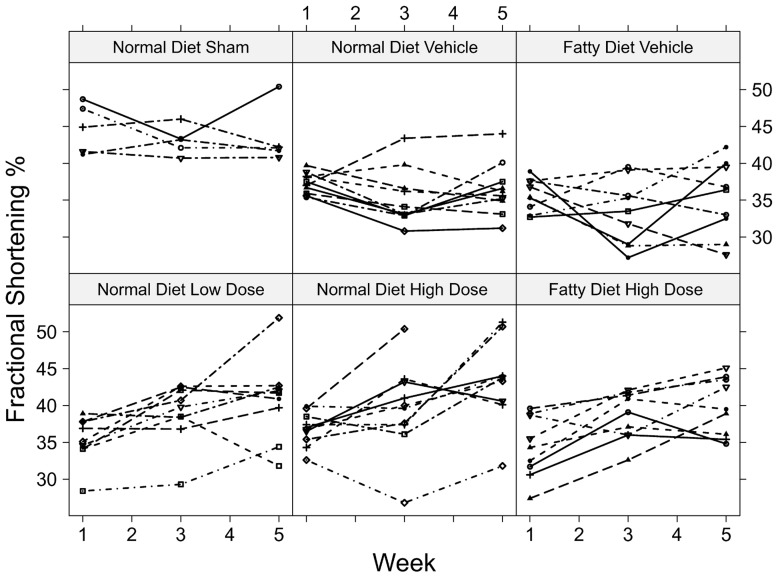
Effect of GGF2 treatment on cardiac function early after MI.Serial measurements of fractional shortening (FS) were acquired from post-MI rats at baseline (1 week post-MI), 2 weeks after GGF2 treatment, and 4 weeks after GGF2 treatment. Echocardiographic assessment revealed that residual left ventricular (LV) FS% values were significantly higher (p = 0.0001) in GGF2 treated animals compared to those in the vehicle groups at the end of the study. The estimated mean FS% and range at 35 days post MI was 43.6 (41.0, 46.3) for the high dose treated group (n = 9), 42.0 (39.1, 45.0) for the low dose treated group (n = 9), and 36.6 (34.2, 39.1) for the vehicle group (n = 10. Individual rat FS % values trended downwards in the vehicle animals with time, whereas a progressive increase in FS % was observed in both the low dose and high dose GGF2 treatment groups. Moreover, the results indicate that high-fat feeding did not impair the effects of high dose GGF2 treatment on cardiac function.